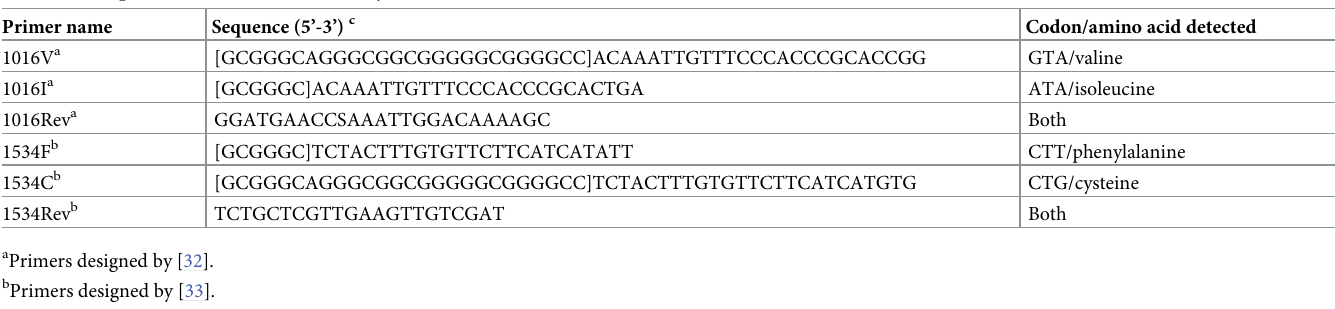
Table 2. PCR primers used for kdr allele